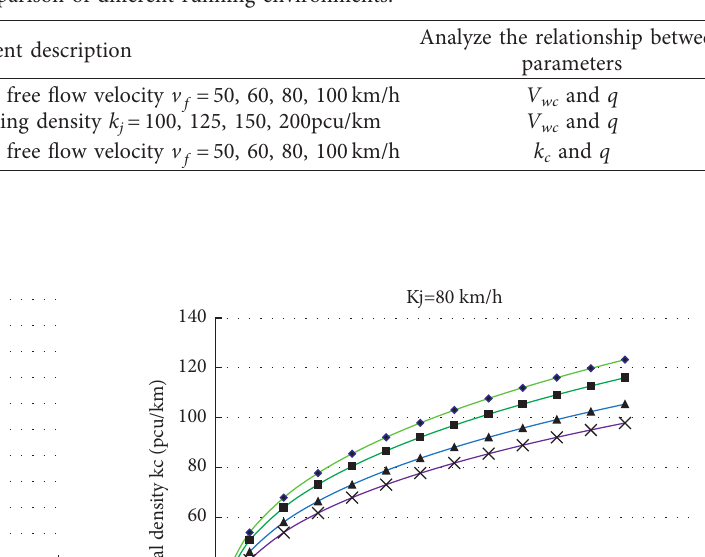
Table 5: Case comparison of different running environments.